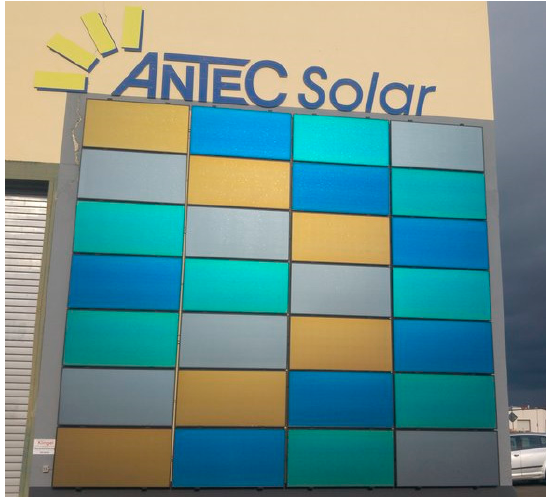
Figure 4. Multi-color solar wall Antec Solar headquarters in Arnstad Germany (source: [37]).